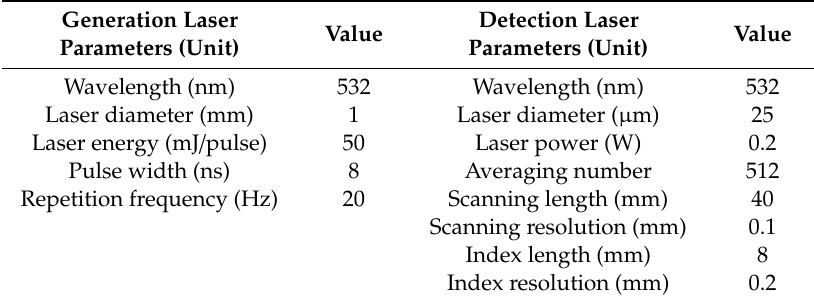
Figure 2. Setup for the laser ultrasonic testing (LUT) system: ( a ) photography and ( b ) principle scheme. Table 2. LUT parameters used for the target sample.